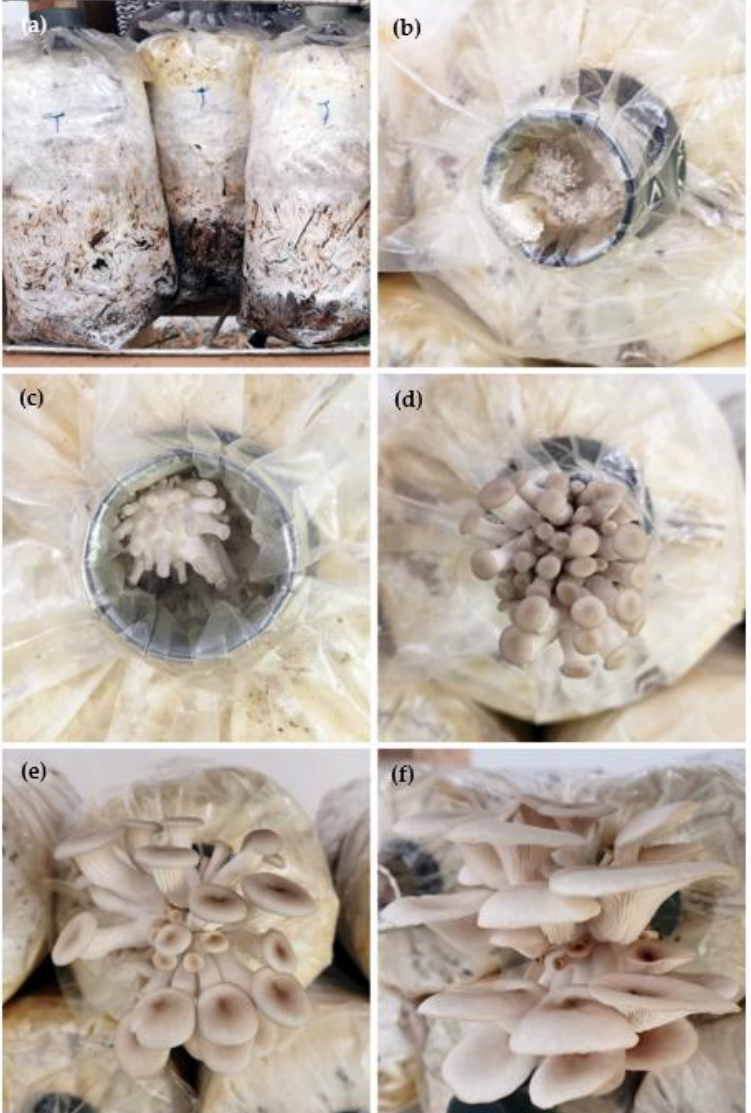
Figure 1. Growth stages of Pleurotus ostreatus . ( a ) Mycelia colonisation of substrate, ( b ) initiation of primordia, ( c ) early development of primordia, ( d ) later development of primordia, ( e ) early development of fruiting bodies, and ( f ) fruiting bodies ready to be harvested.